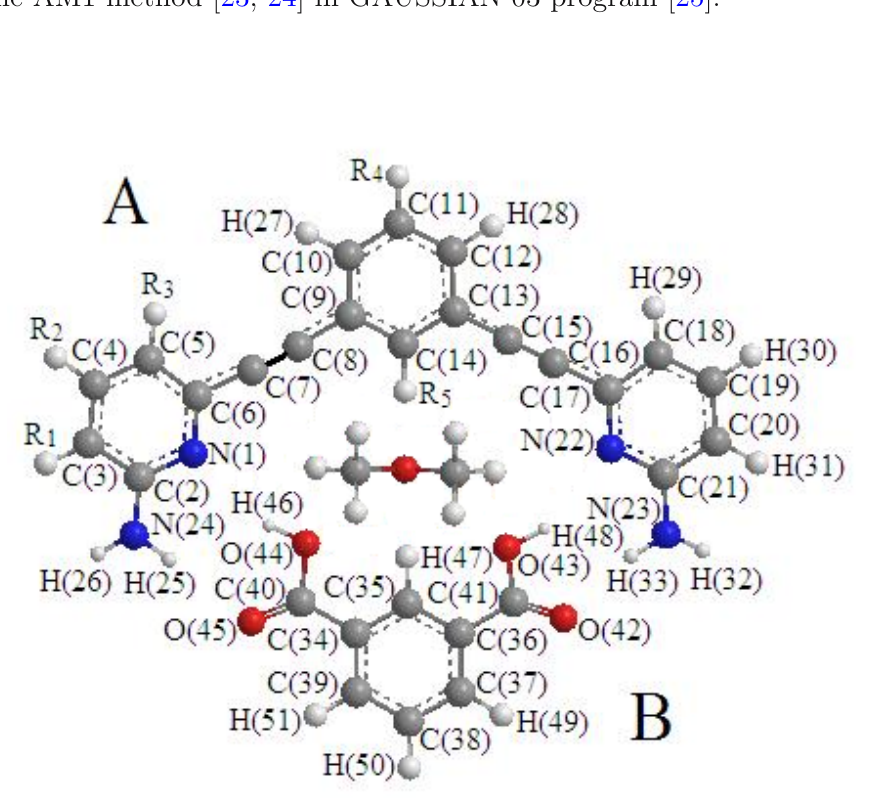
Fig. 1 AM1 optimized geometry of complex